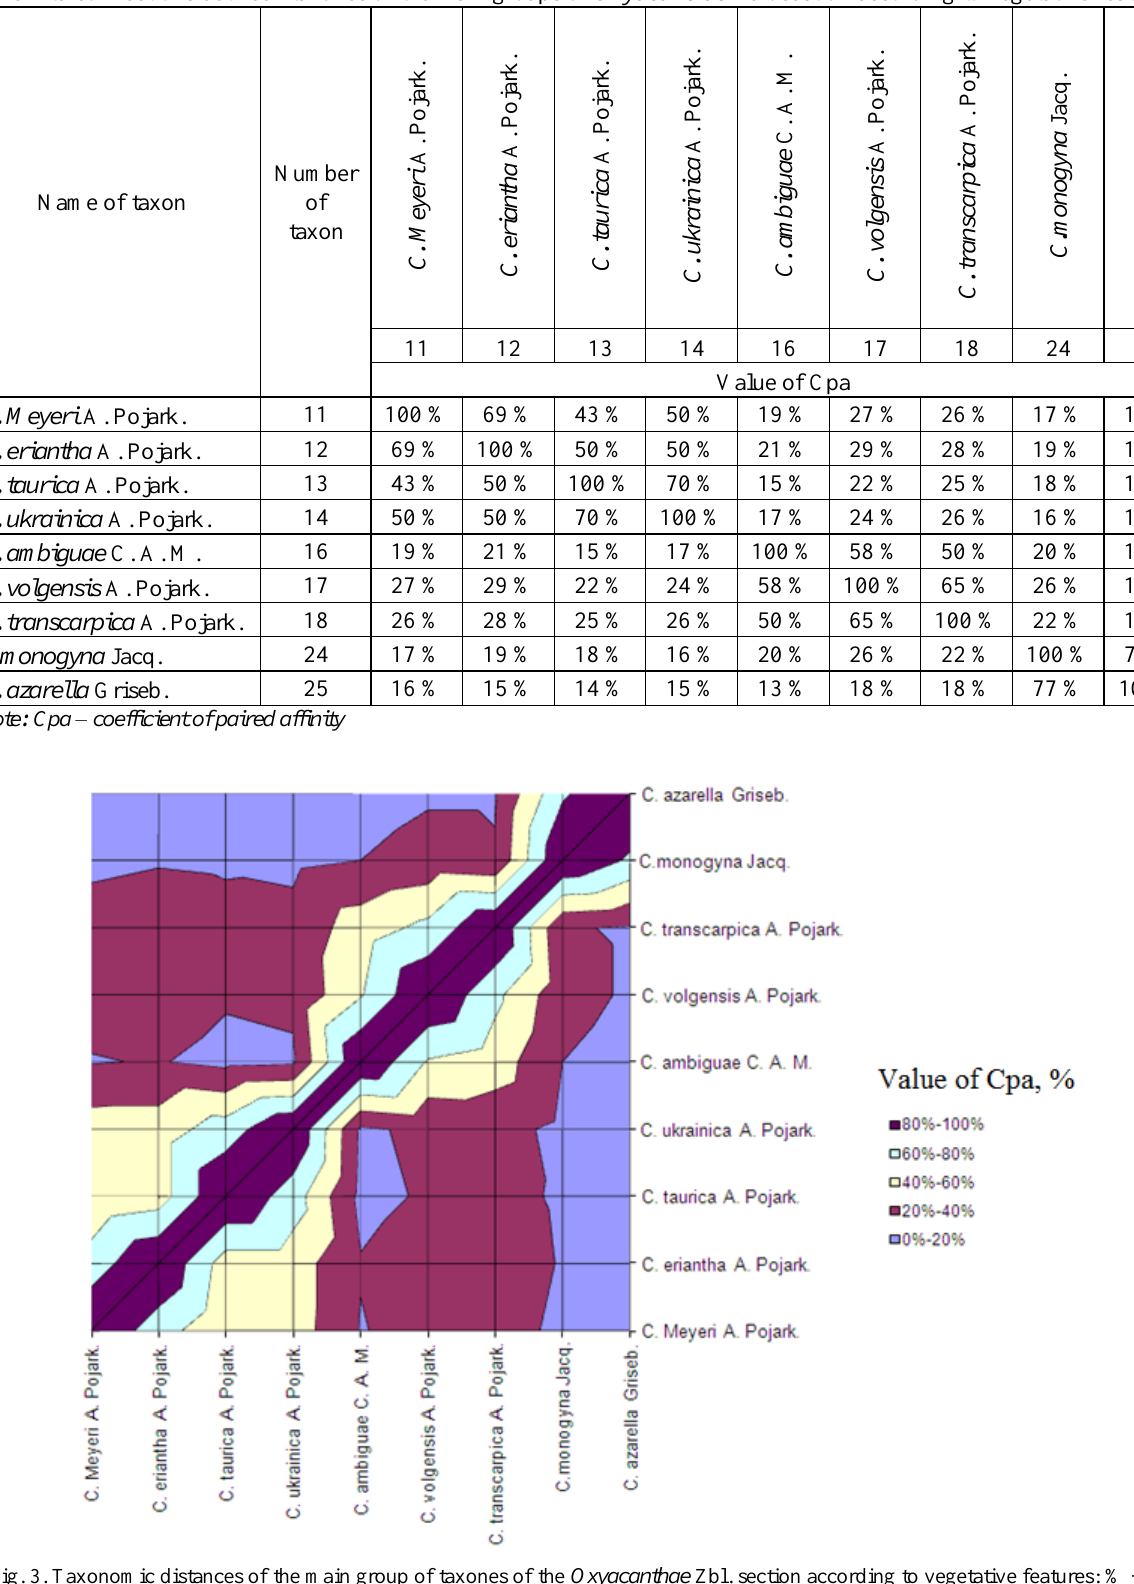
Fig. 3. Taxonomic distances of the main group of taxones of the Oxyacanthae Zbl. section according to vegetative features: % - the value of Cpa of taxones of the main